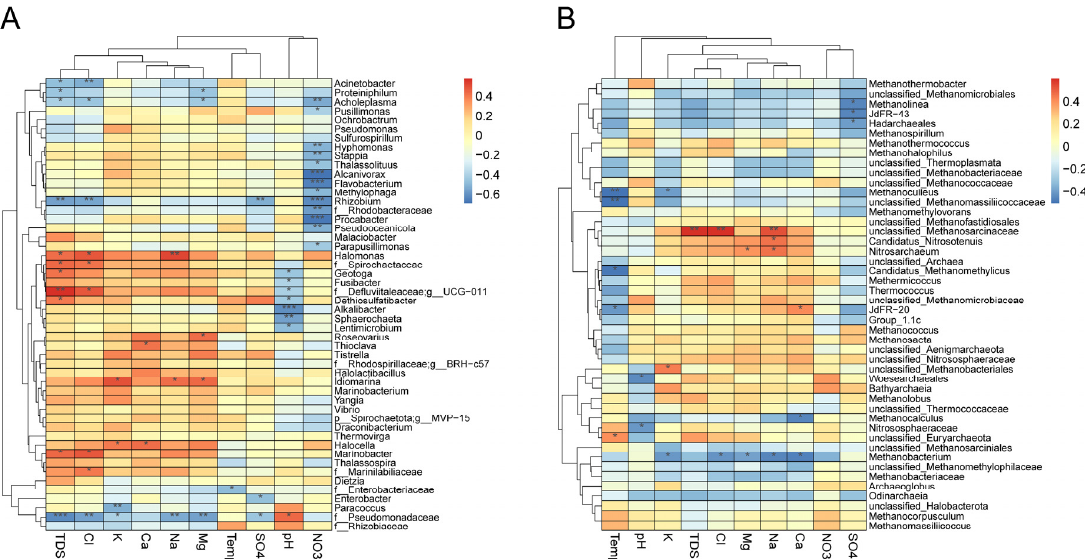
Figure 6. Heatmap of Spearman’s correlation between relative abundances of microbial taxa and physiochemical parameters. ( A ) taxonomic association with physicochemical parameters of the top 50 bacterial genera. ( B ) taxonomic association with physiochemical parameters of archaeal genera. Negative correlation and positive correlations are indicated by blue and red colors, respectively. * indicates 0.01 < p ≤ 0.05, ** indicates 0.001 < p ≤ 0.01, *** indicates p ≤ 0.001.